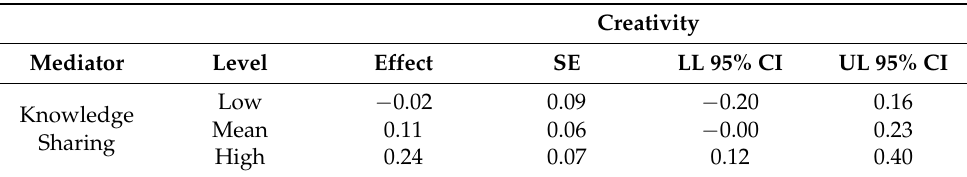
Table 5. Conditional indirect effects of coworkers’ helping behavior on creativity at values of interactional